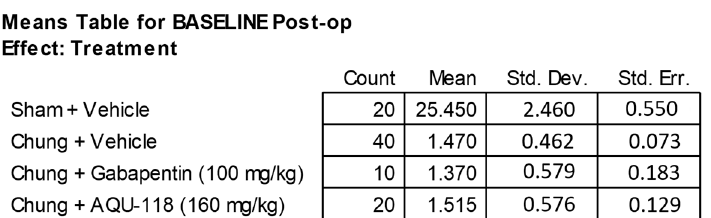
Figure A1. Statistical analysis of post-operative von-Frey (VF) baseline paw withdrawal threshold (PWT) of the ipsilateral hind paws. All Chung surgical groups showed a significant decrease in the PWT compared to the sham surgical group. No significant difference in post-operative baseline PWT was detected between the individual Chung surgical groups.